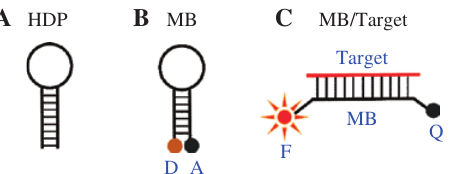
Figure 1: Hairpin probes and basic detection